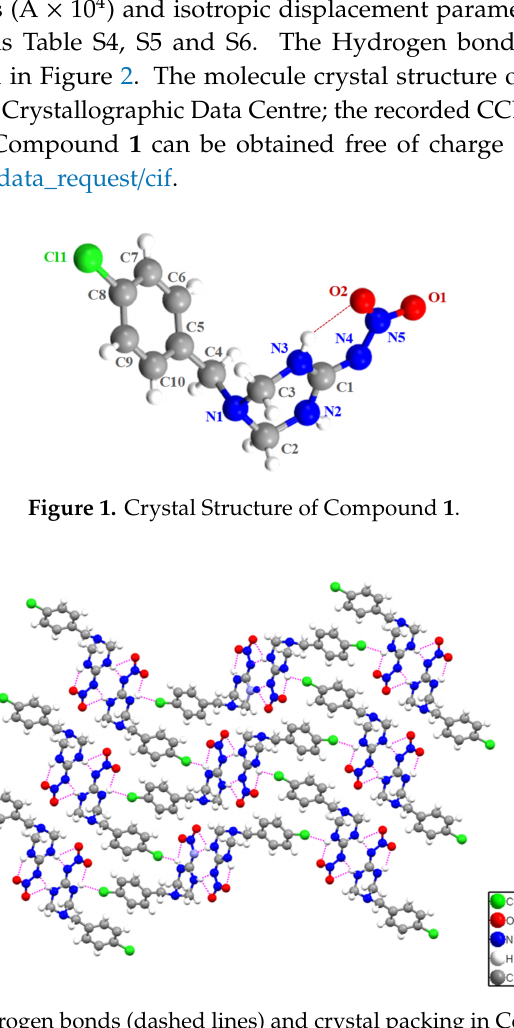
Figure 2. Hydrogen bonds (dashed lines) and crystal packing in Compound 1